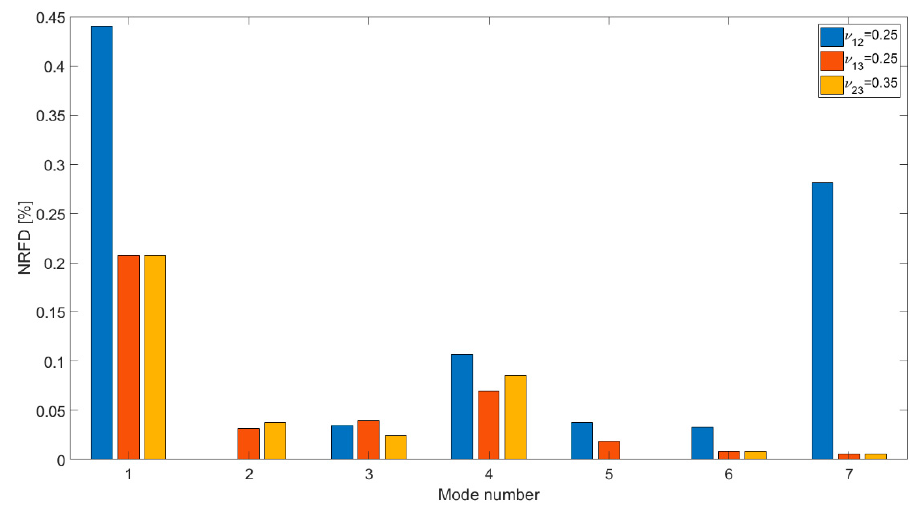
Figure 9. NRFDs of Poisson’s ratios.